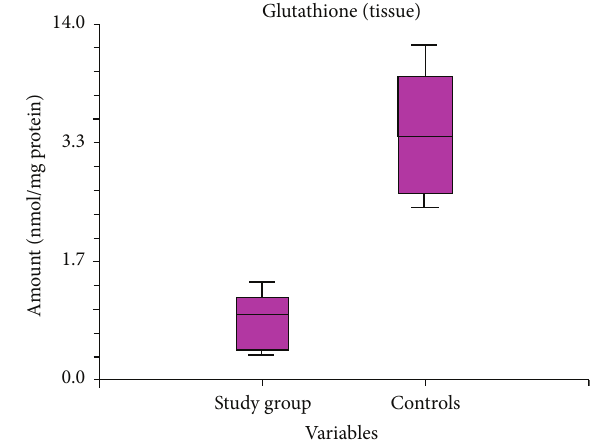
Figure 2: Comparison between GSH tissue levels in diabetics versus